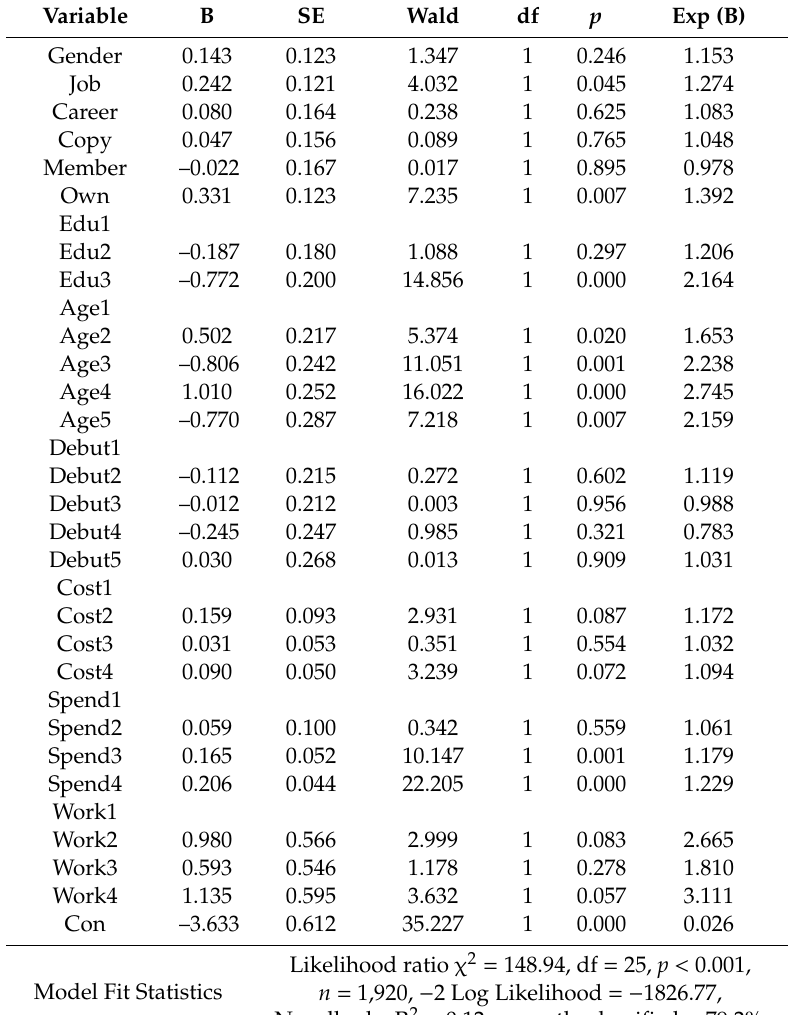
Table 3. Results of logistic regression analysis.